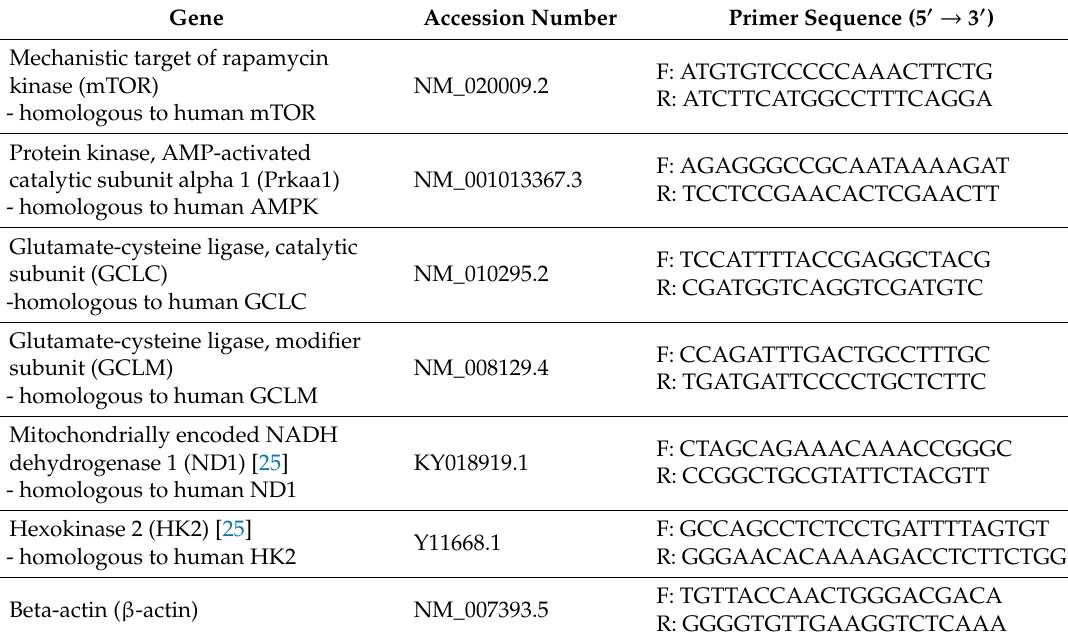
Table 1. Primer sequences used in real-time PCR